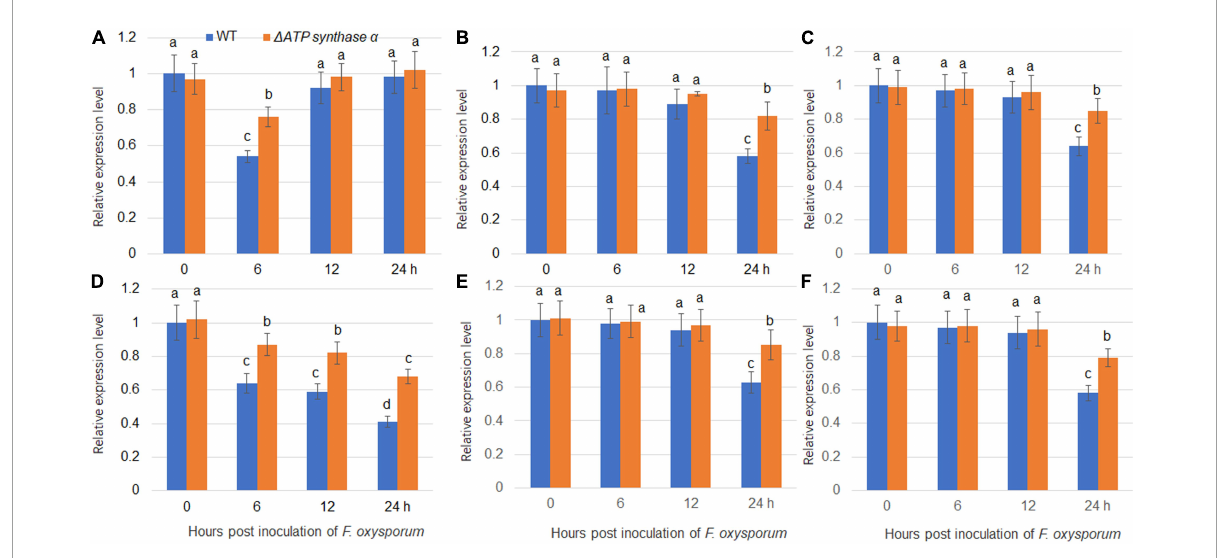
FIGURE6 Expression of sugar transporters in tobacco plants following inoculation with wild-type and (cid:49) FoATP synthase α mutant strains of Fusarium oxysporum . The expression of NtSUC4 (A) , NtSTP12 (B) , NtHEX6 (C) , NtSWEET1 (D) , NtSWEET3b (E) , and NtSWEET12 (F) in tobacco plants was examined 0-, 6-, 12-, and 24-h post inoculation with wild-type (blue bars) and (cid:49) ATP synthase α mutant (red bars) strains. Different letters above the bars indicate significant differences ( P <